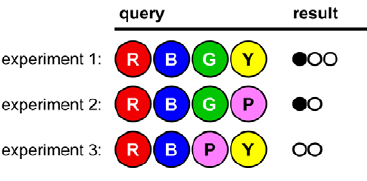
Figure 2. A game opening illustrating Lesson 1.